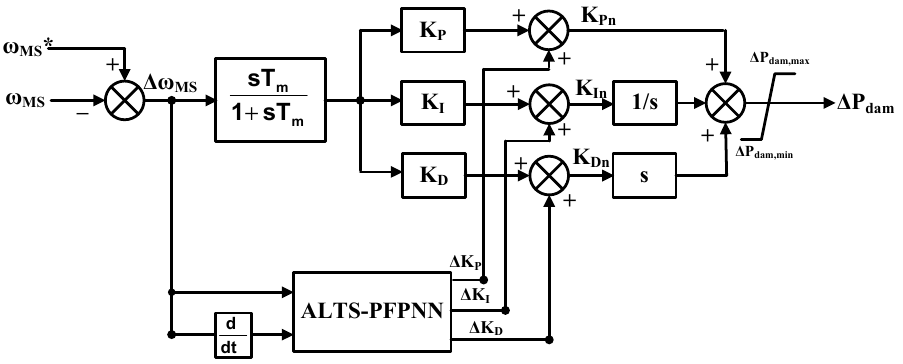
Figure 5. The structure of an ALTS-PFPNN.